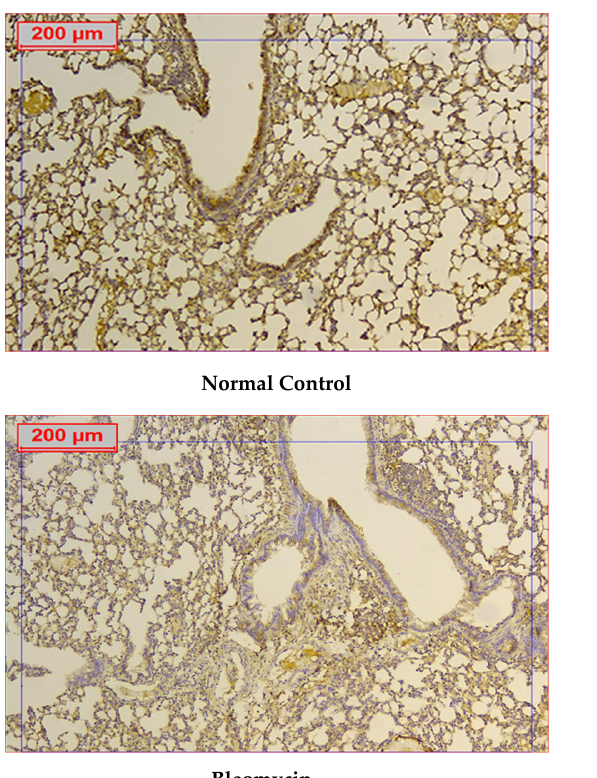
Figure 7. The effect of meleagrin on the protein expression levels of Bax in the lung tissue of the experimental mice determined by immunohistochemistry. Bax = B cell lymphoma-2 associated X protein. Data of the percentage of positive stained area are expressed as mean ± SD and analyzed using one-way ANOVA followed by Bonferroni’s post hoc test ( n = 8). * significantly different vs. the normal control group; # significantly different vs. the meleagrin group; ^ significantly different vs. the bleomycin group. Differences were considered significant at p < 0.05.